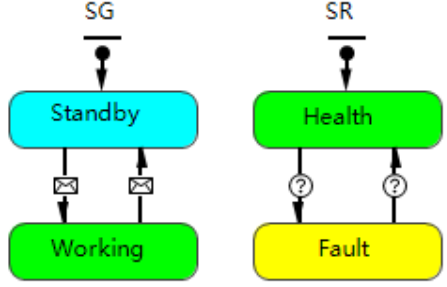
Figure 4. The icon for system agent.